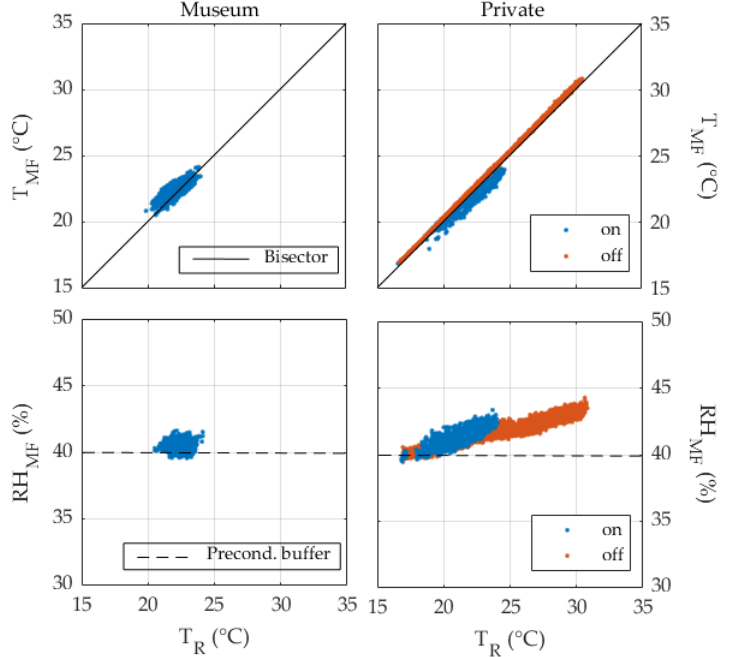
Figure 3. Scatter diagram of simultaneous temperature (T R ) and relative humidity values (RH R ) in the rooms versus values inside the microclimate frame (T MF and RH MF ) during a solar year. In Private, the data points are grouped based on whether the intermittent heating system is active (on) or not